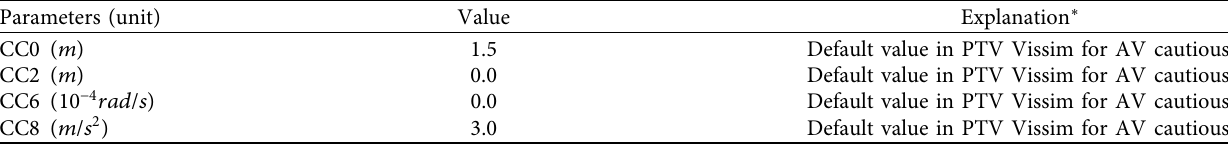
Table 9: Default parameters to simulate Lv2 AV behavior using the Wiedemann 99 model.